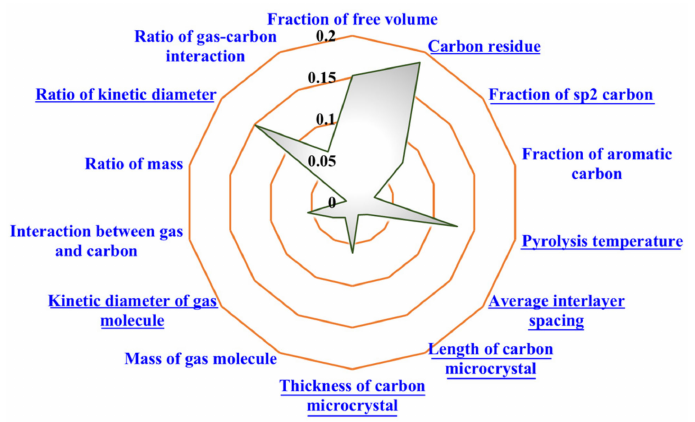
Figure 9. The normalized weight of the influencing factors on characteristic distance (factors with underline are